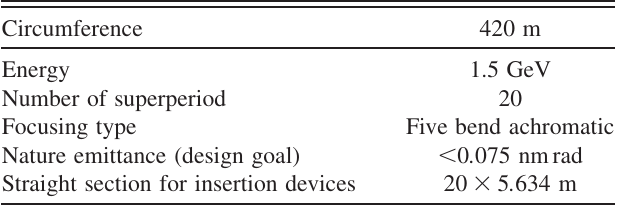
TABLE I. The main design properties of the ultralow emit- tance lattice.